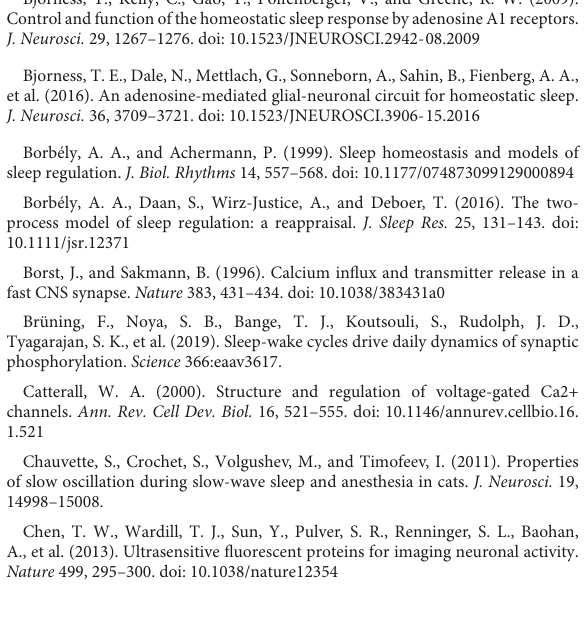
SUPPLEMENTARYFIGURE1 Sample EEG Delta Power and Hypnogram Plots over 24 h for Vehicle and Nicardipine Treatment. Power in the EEG delta (0.5–4 Hz) band (top) and hypnogram (bottom) from one mouse plotted against time for two non-consecutive 24 h recordings. Light (inactive) phase from ZT0 to ZT12 and dark (active) phase from ZT12 to ZT24. The graph on the left is the vehicle condition (indicated by the blue vertical bar), and the graph on the right is the nicardipine condition (indicated by the yellow vertical bar). (A) Injection of vehicle and nicardipine at ZT0. (B) Injection of vehicle and nicardipine at ZT 12. (C) Injection of vehicle and nicardipine at ZT4 after 4 h of sleep deprivation from ZT0 to ZT4. SUPPLEMENTARYFIGURE2 Vigilance State Plots at 1-h Intervals for Vehicle and Nicardipine Treatment. Plots of vigilance state duration in minutes per 1 h bin (top, wake; middle, NREM sleep; bottom, REM sleep) over 24 h. Data is mean ± SEM for N = 7 animals. ZT0–ZT12 is the light (inactive) phase, and ZT12–ZT24 is the dark (active) phase. Data from ICV vehicle treatment in orange, from ICV nicardipine treatment in blue. Treatment is indicated by the gray vertical bar. (A) Treatment time ZT0. (B) Treatment time ZT12. (C) Treatment time ZT4 after sleep deprivation from ZT0 to ZT4. P -values on top of graphs are from two-way repeated measures ANOVA for treatment effect. There was no significant difference between treatment conditions for any vigilance